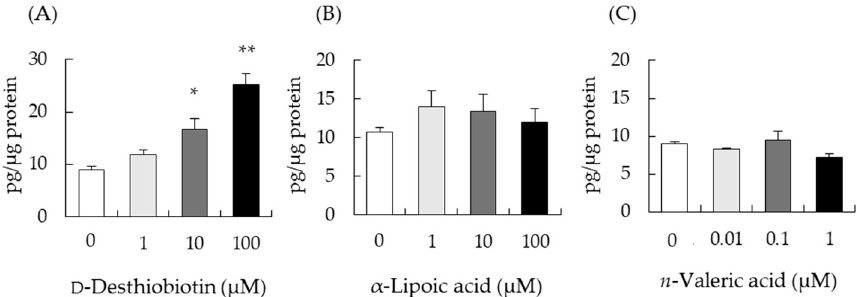
Figure 5. The effect of biotin-analogues on testosterone production in I-10 cells, 24 h post-treatment. Shown are the testosterone levels in I-10 cell cultured media, treated with D -desthiobiotin ( A ), α -lipoic acid ( B ), or n -valeric acid ( C ) for 24 h, measured by ELISA. Data are presented as mean ± standard error (n = 3). * p < 0.01, ** p < 0.0 vs. 0 µ M group,